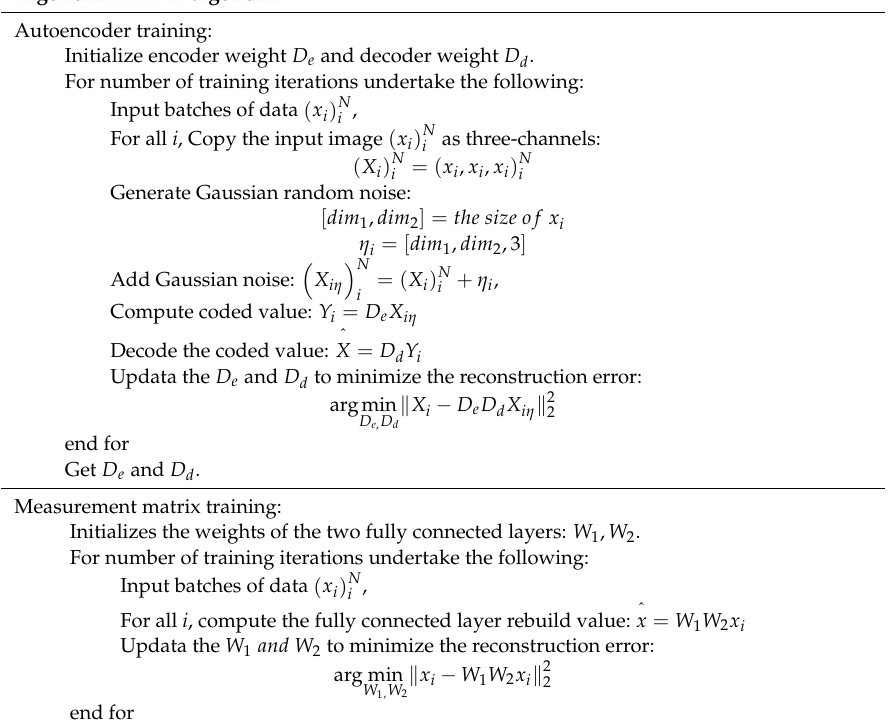
Algorithm 1 DPAP